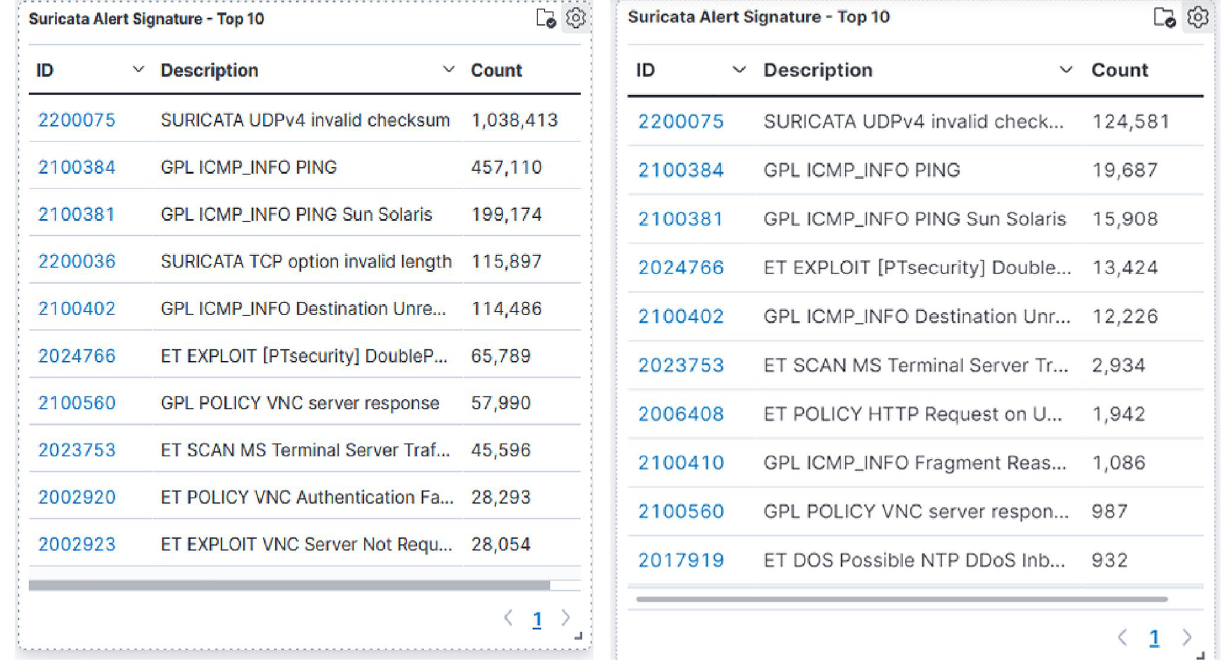
Figure 12. Details of alert signatures identified by the honeypot